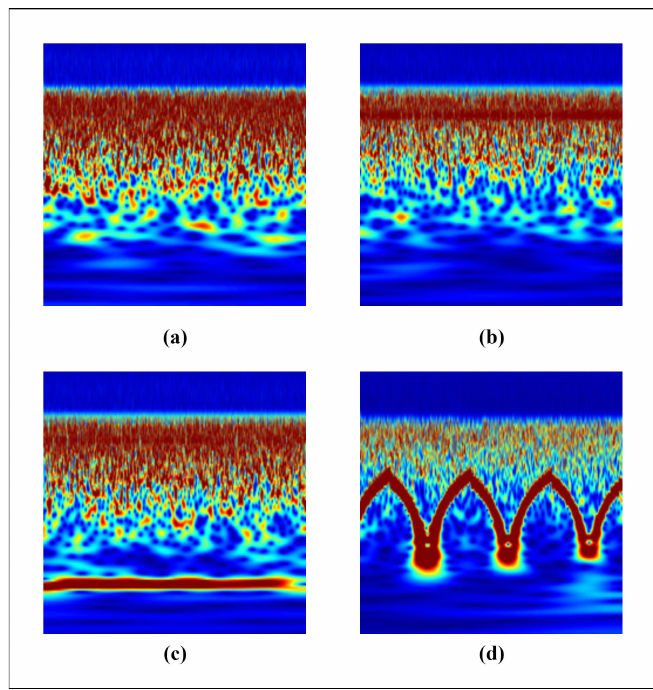
Figure 3. Scalogram representation of target classes: ( a ) SoI, ( b ) SoI+CWI, ( c ) SoI+MCWI, and ( d )